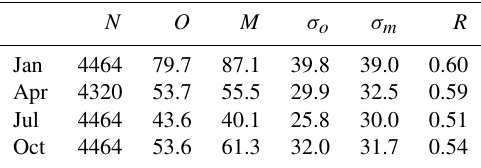
Table 2. Statistical summary of the comparisons of the monthly average NO 2 between simulation and